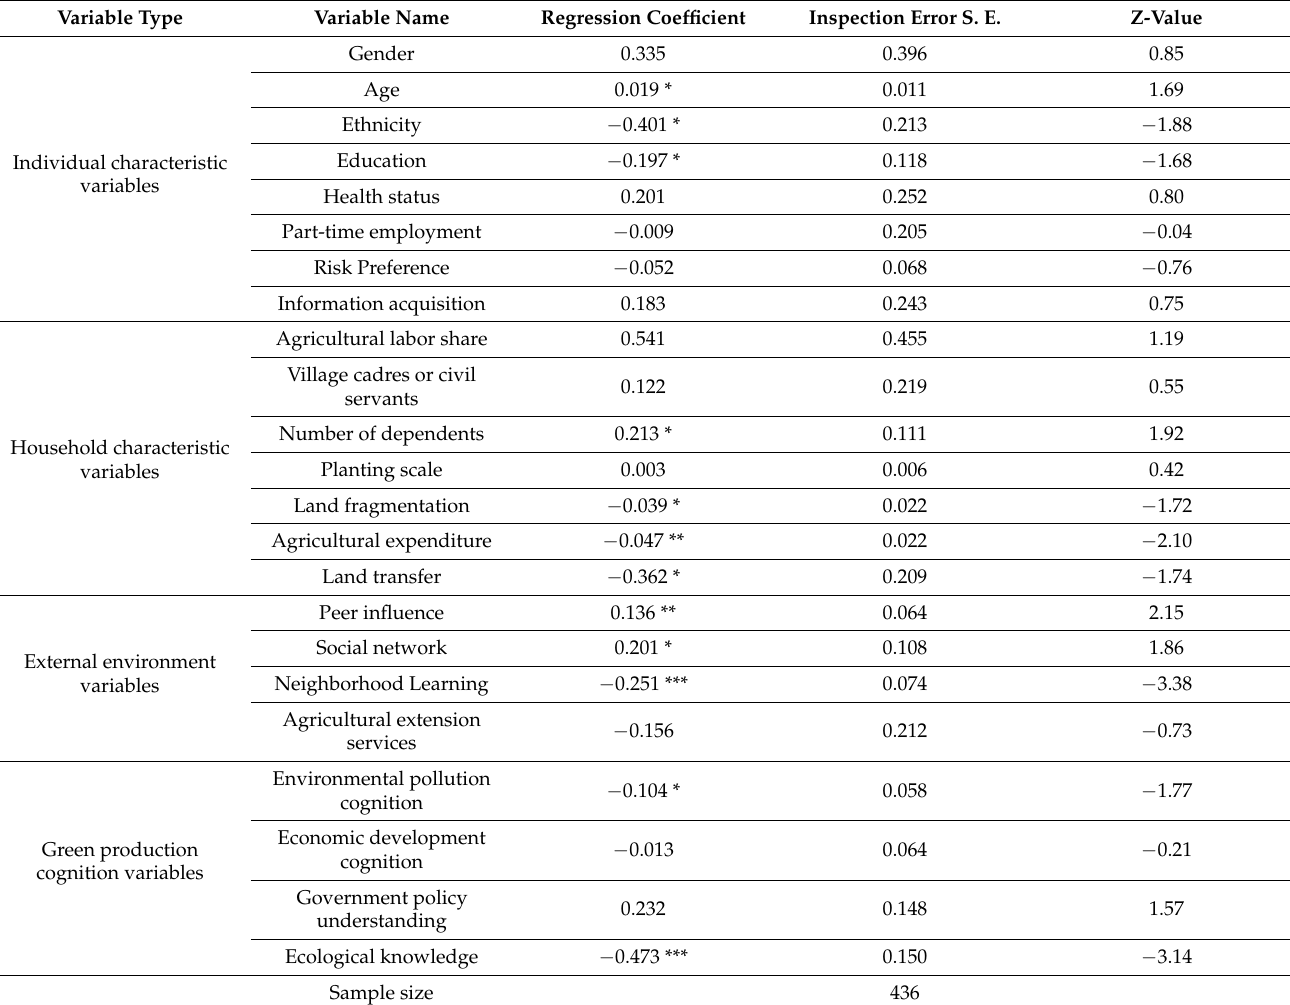
Table 4. Regression results of the ordered logit